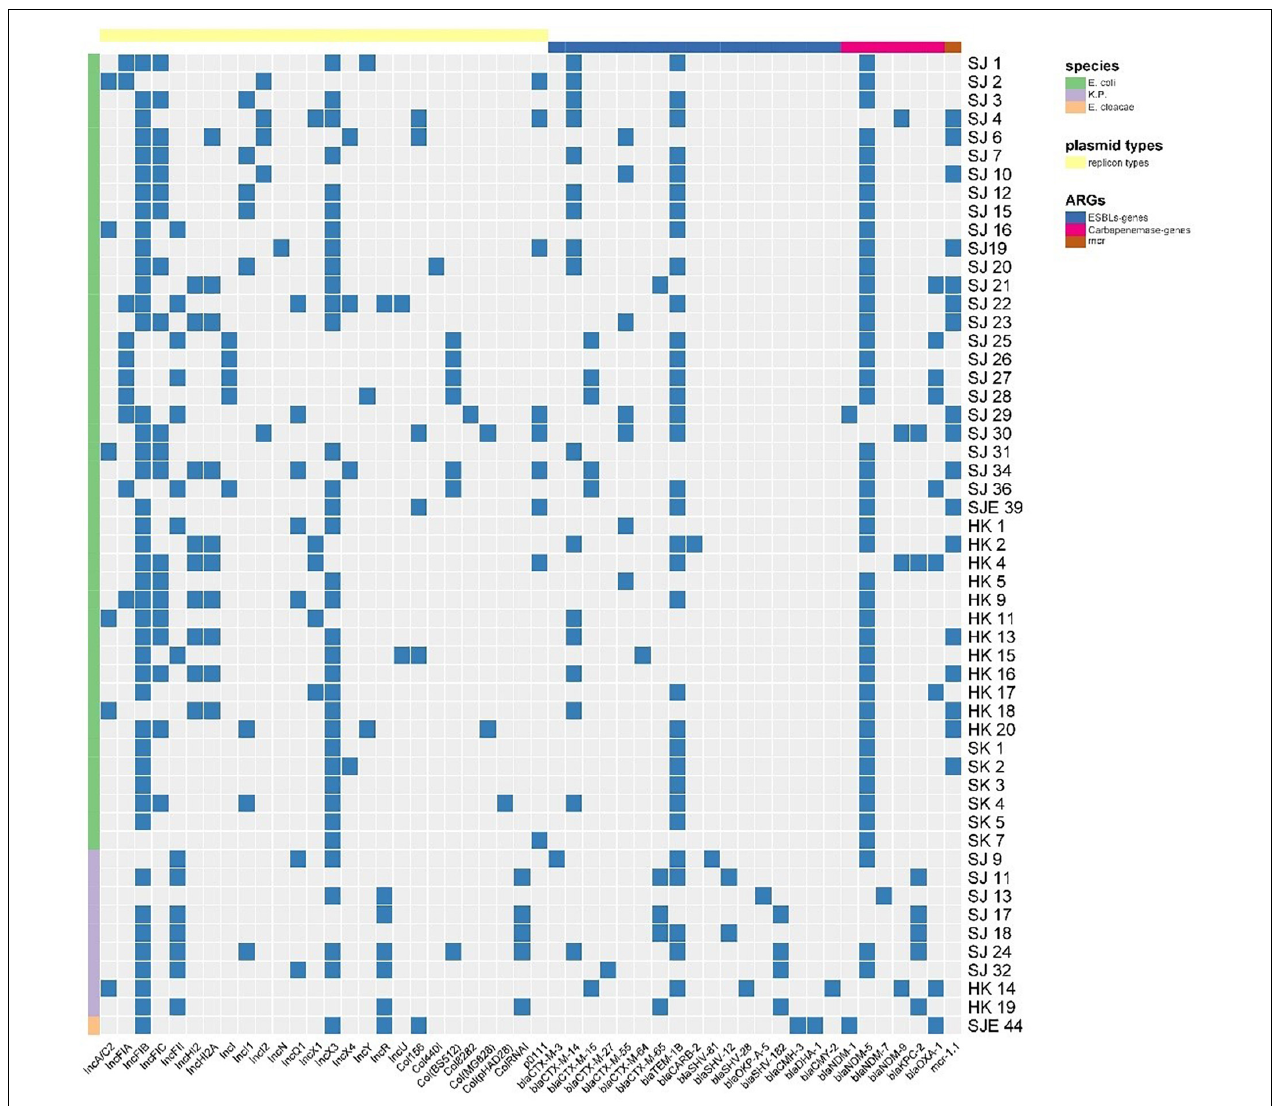
FIGURE 5 | A heat map showing the plasmid replicon types, ESBL genes, CR genes, and mcr-1 gene of 53 CRE strains. The Col group was split into three groups according to species. In accordance with plasmid replicon types and different categories of ARGs, the raw group was separated into four